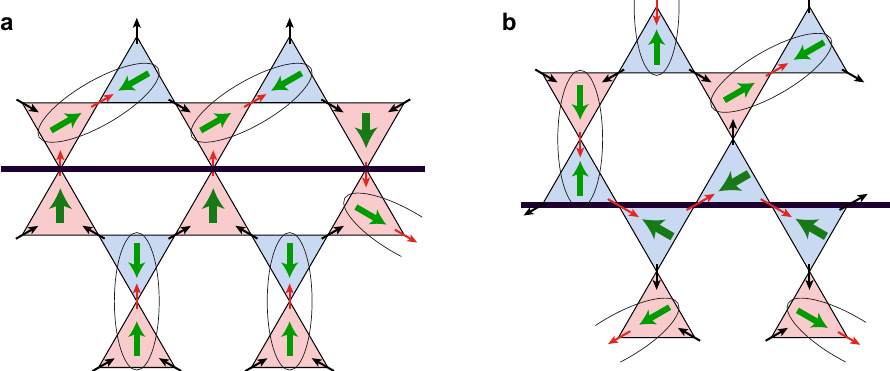
Fig. 4 Dipole structure of domain walls in kagome systems with moment fragmentation. a , b Monopole domain walls of type 1 and 2. There are unpaired dipoles on domain walls of both types. The situation would be in principle similar for pyrochlore systems with moment fragmentation (shown in Fig. S4 of the Supplementary on the trajectory of these defects new ( d , − d ) pairs, see the Fig. 2c (effectively destroying the dipoles of the ( d , − d ) dimer Supplementary Information. on these neighbouring sites), then moving these defects apart we automatically recommute spins in such a way as to create